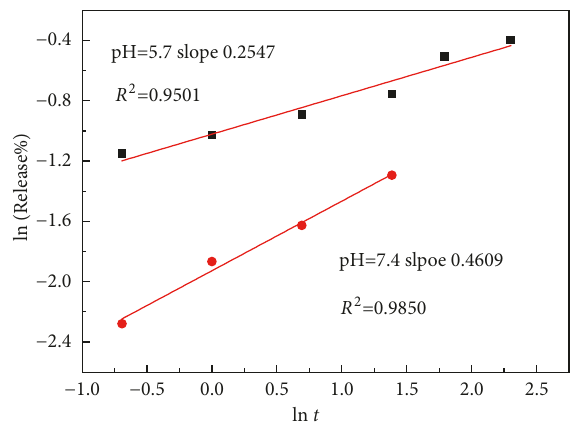
Figure 9: Natural logarithm of the drug release rate as a function of ln t in the early stage of drug release.